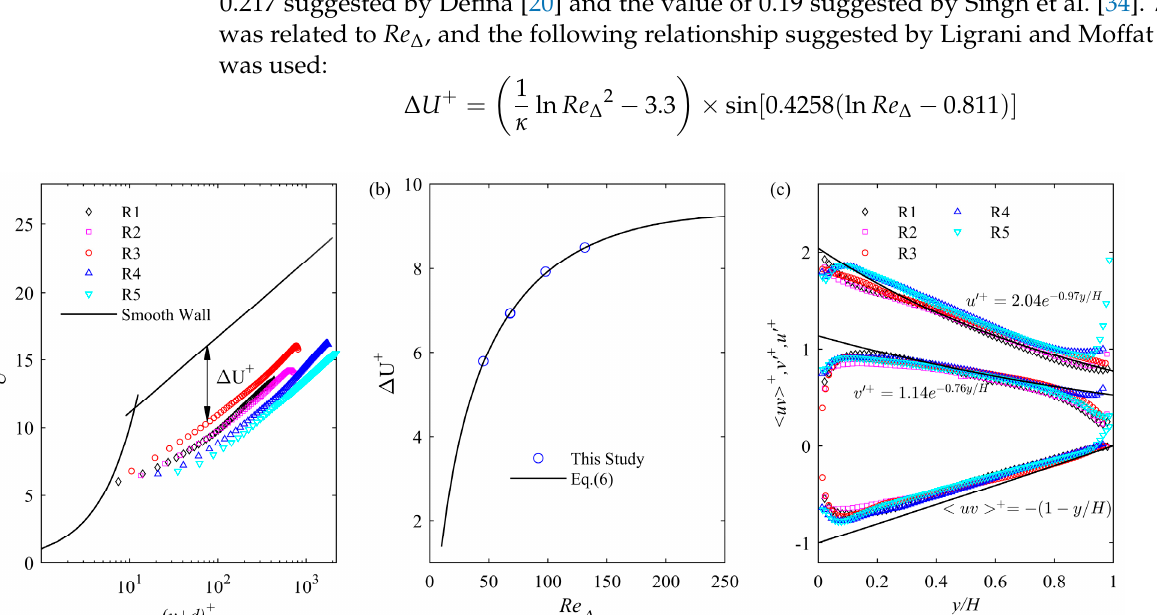
Figure 2. ( a ) Wall-normal pro fi le of mean velocity. ( b ) Roughness function versus the roughness Reynolds number. ( c ) Wall-normal pro fi les of turbulence intensities and Reynolds stress.